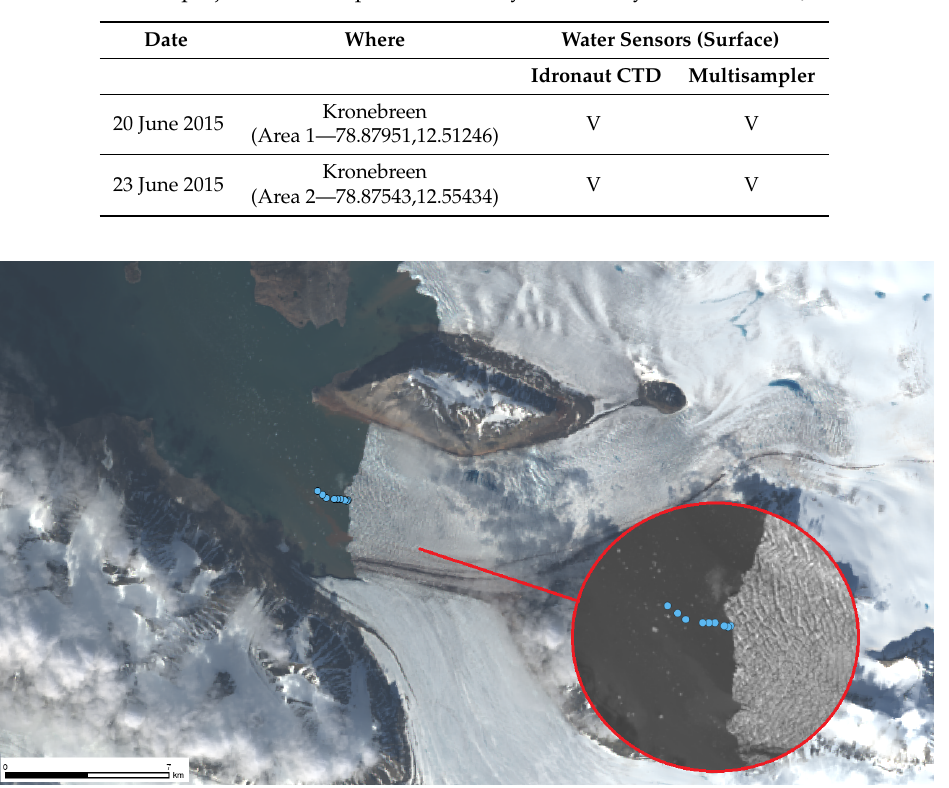
Figure 13. ARCA project: Shark USSV path to reach Kronebreen glacier front, 23 June 2015. The map of the fjord is obtained from the processing of Landsat8 data acquired on the same days of the